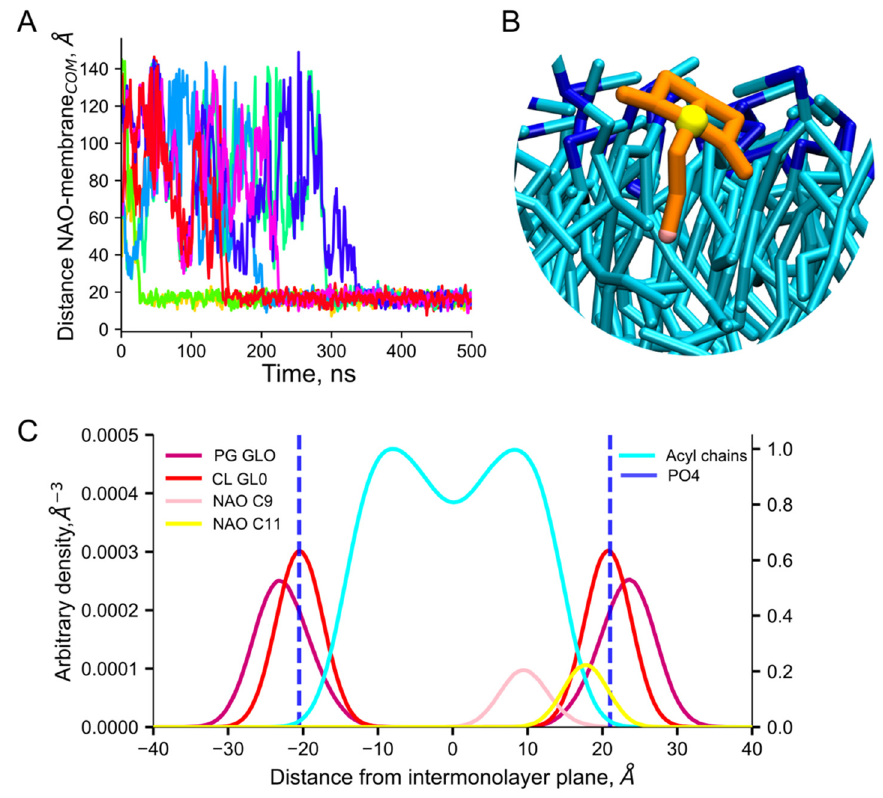
Figure 4. Insertion of NAO into the model bilayer. Distance between the center of mass of modeled bilayer and NAO shown in different colors for individual NAO molecules ( A ). Representative conformation of inserted NAO molecule (charged bead of NAO is shown as yellow sphere; terminal bead of NAO is pink; other NAO beads are shown as orange sticks; the acyl chains of lipids are shown as cyan sticks; lipid phosphates are shown as blue sticks) ( B ). The density profiles of key chemical moieties of NAO and lipids along the membrane normal. Blue dashed lines correspond to the average position of lipid phosphates ( C ).